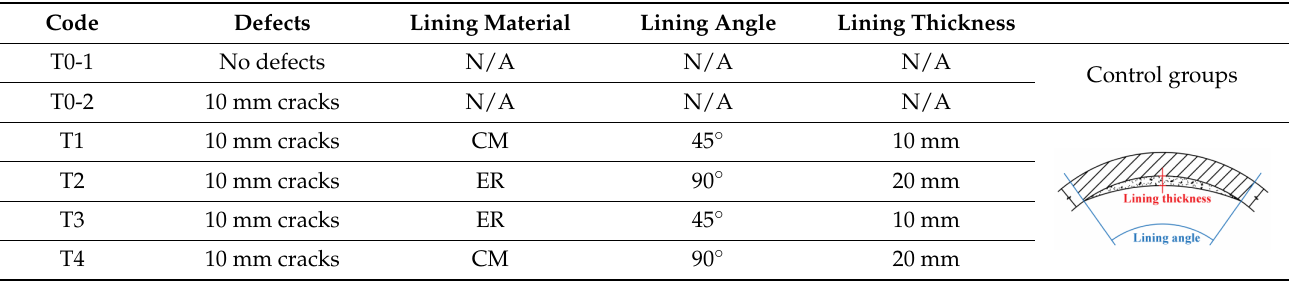
Table 1. Designing and coding of TEBTs. Code Defects Lining Material Lining Angle Lining Thickness